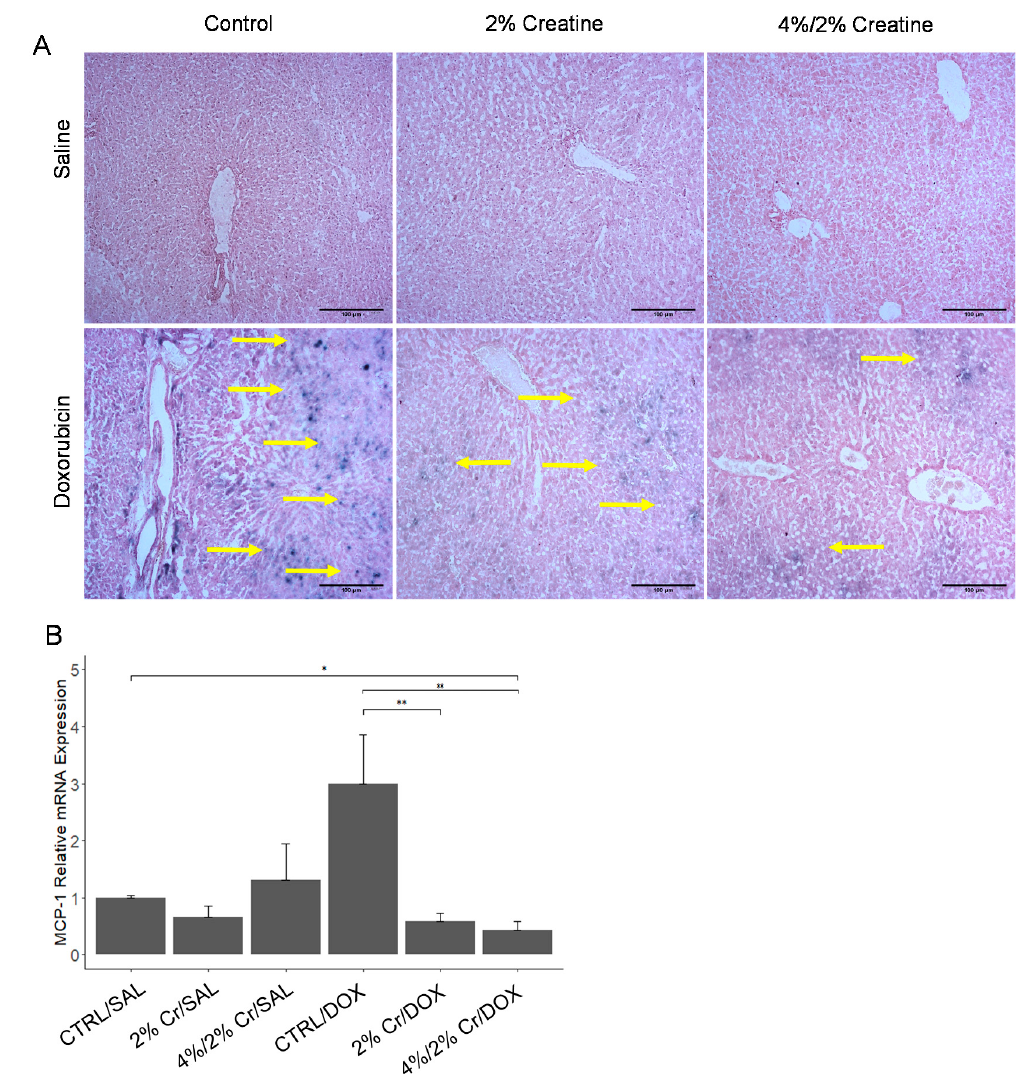
Figure 5. Liver senescence was measured using β -galactosidase staining and qRT-PCR. Histologically, no senescence was observed in control groups (top row), while more senescence (bottom row) was observed in groups that received DOX treatment. Both 2%Cr/DOX and 4%/2%Cr/DOX showed decreased senescence when compared to CTRL/DOX. The blue spot indicates the senescence sites (yellow arrow) ( A ). Images were obtained under 20× magnification. mRNA expression of MCP-1 was highest in CTRL/DOX but decreased in groups receiving Cr supplementation when compared to CTRL/DOX ( B ). Six biological replicates are used, and mRNA expression is relative to ACTB. Data is reported as mean ± SE. * p < 0.05, ** p < 0.01.